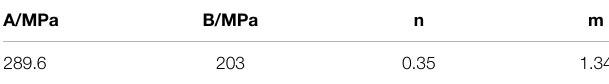
TABLE 1 | Johnson-Cook model material constants of 6082-T6 aluminum alloy. A/MPa